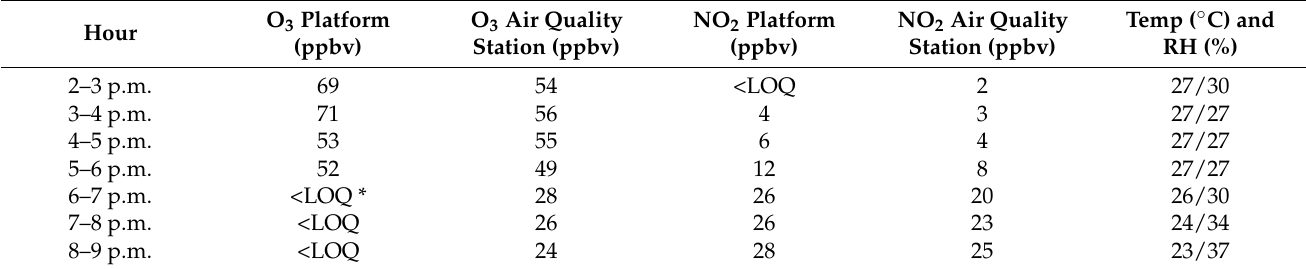
Table 4. Comparative results obtained by the proposed method and the official air quality station. Hour